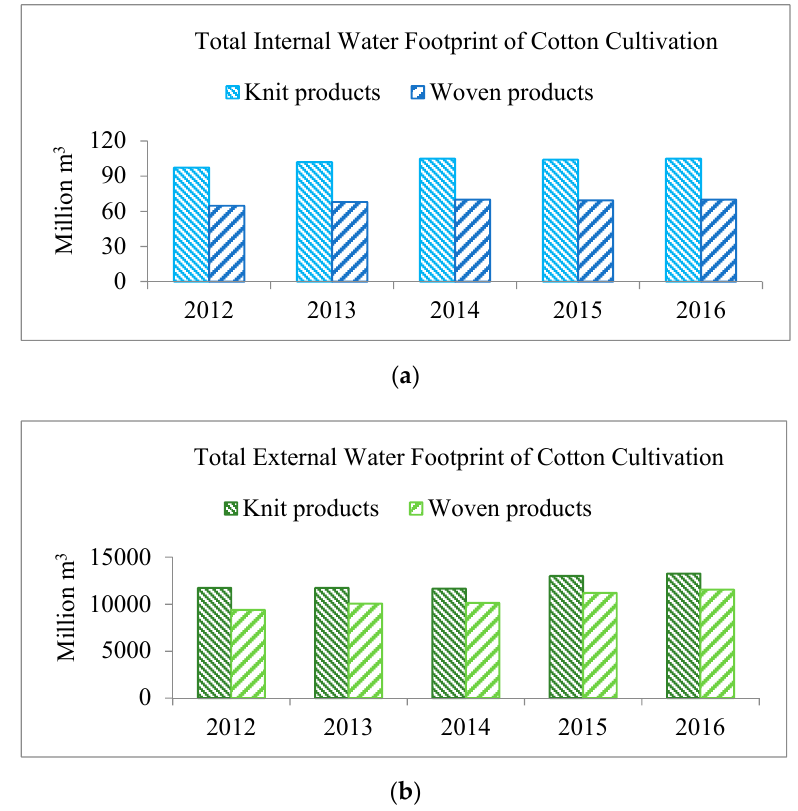
Figure 5. Total water footprint of cotton cultivation ( a ) internal water footprint and ( b ) external water footprint.